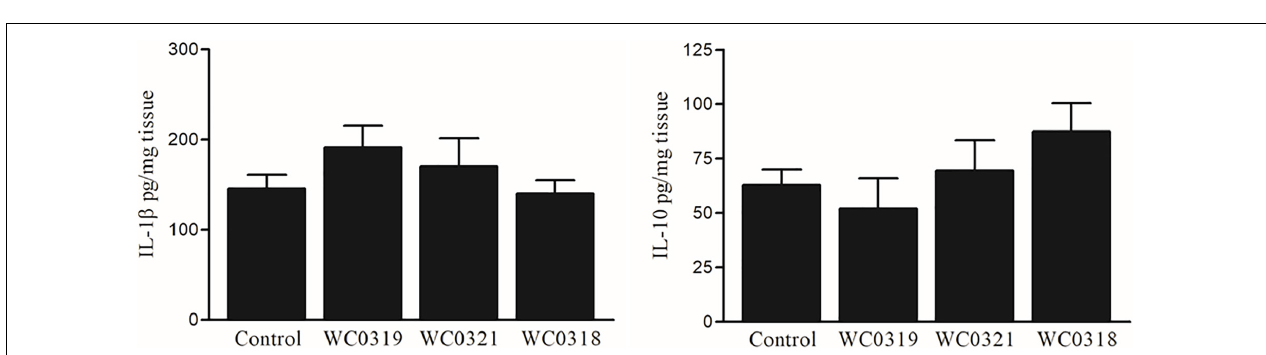
FIGURE 6 | Effect of daily oral supplementation with 5 × 10 8 CFU of Leuconostoc carnosum WC0318, L. carnosum WC0319, and L. carnosum WC0321 on intestinal mucosa immune cells, determined by FACS: (A) DC (CD11c+); (B) CD3 + lymphocytes. * Indicates significant difference versus the control ( p < 0.01, t -test).